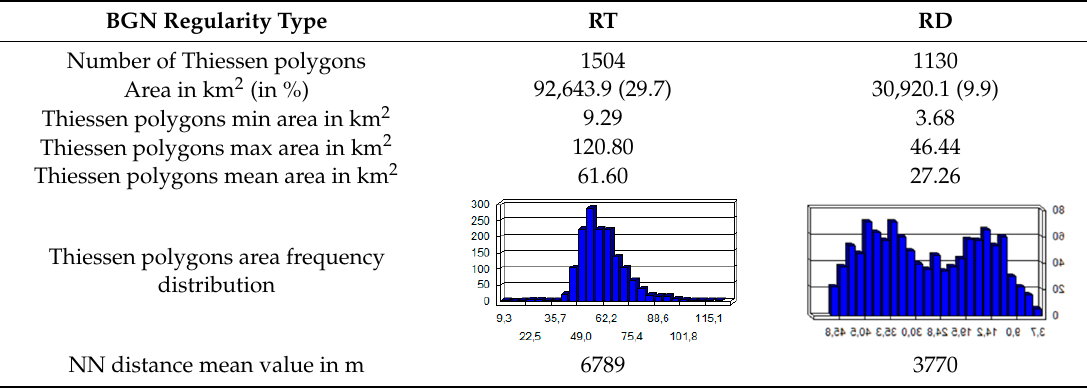
Table 5. Descriptive characteristics of regularly thinned cluster (RT) and regularly dense cluster (RD) regions.